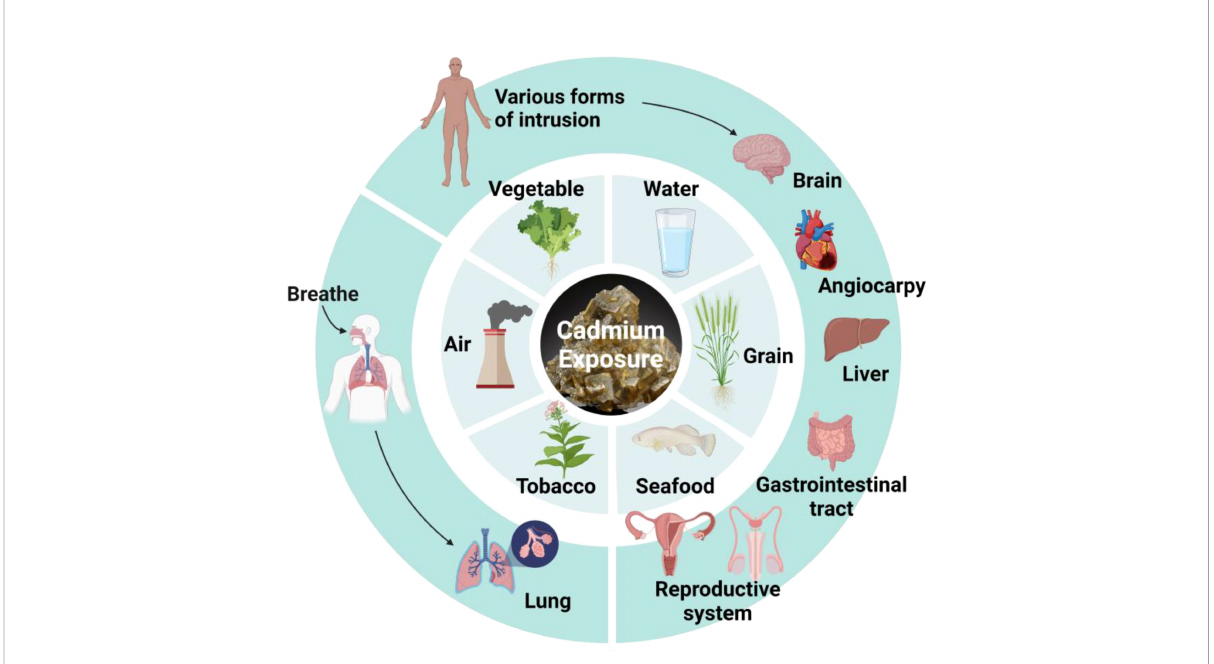
FIGURE 3 Hazards from Cd exposure. Cd can enter the body through air, tobacco, seafood, grain, water, vegetable, and damage different organs.